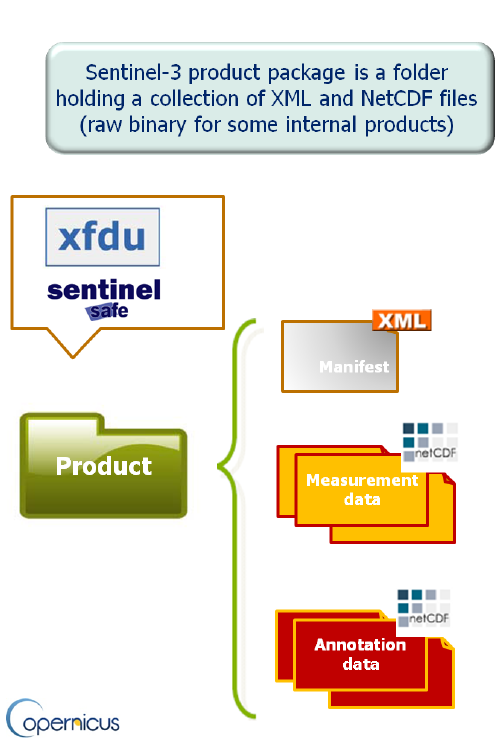
Figure 4. Schematic overview of the SAFE product format.